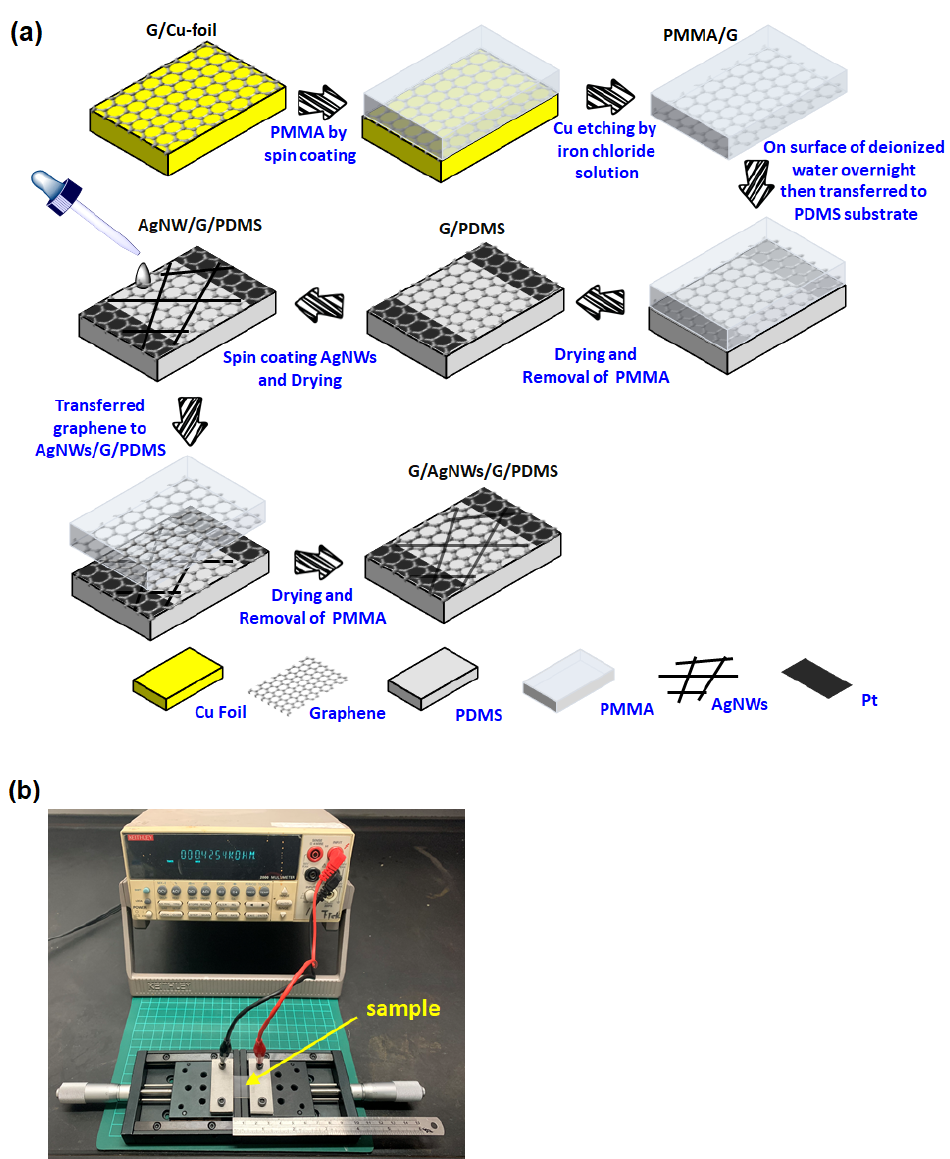
Figure 1. ( a ) Schematic of the fabrication process for the G/AgNW/G sandwich structure. ( b ) Pho- tograph of the in-situ electrical resistance measurement during stretching. ( b ) Photograph of the in-situ electrical resistance measurement during